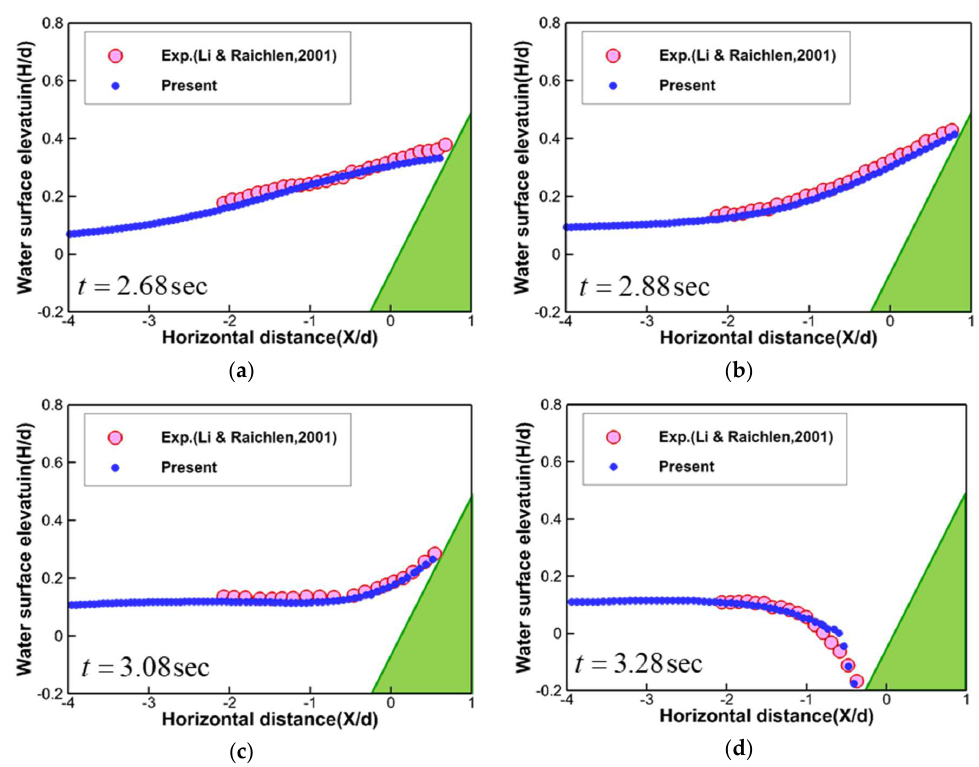
Figure 13. Comparison of time-sequential wave profiles estimated by present simulation and measured by experiment over a slope of 26° in case of H/h = 0.163 at ( a ) t = 2.68 s, ( b ) t = 2.88 s, ( c ) t = 3.28 s, and ( d ) t = 3.08 s.